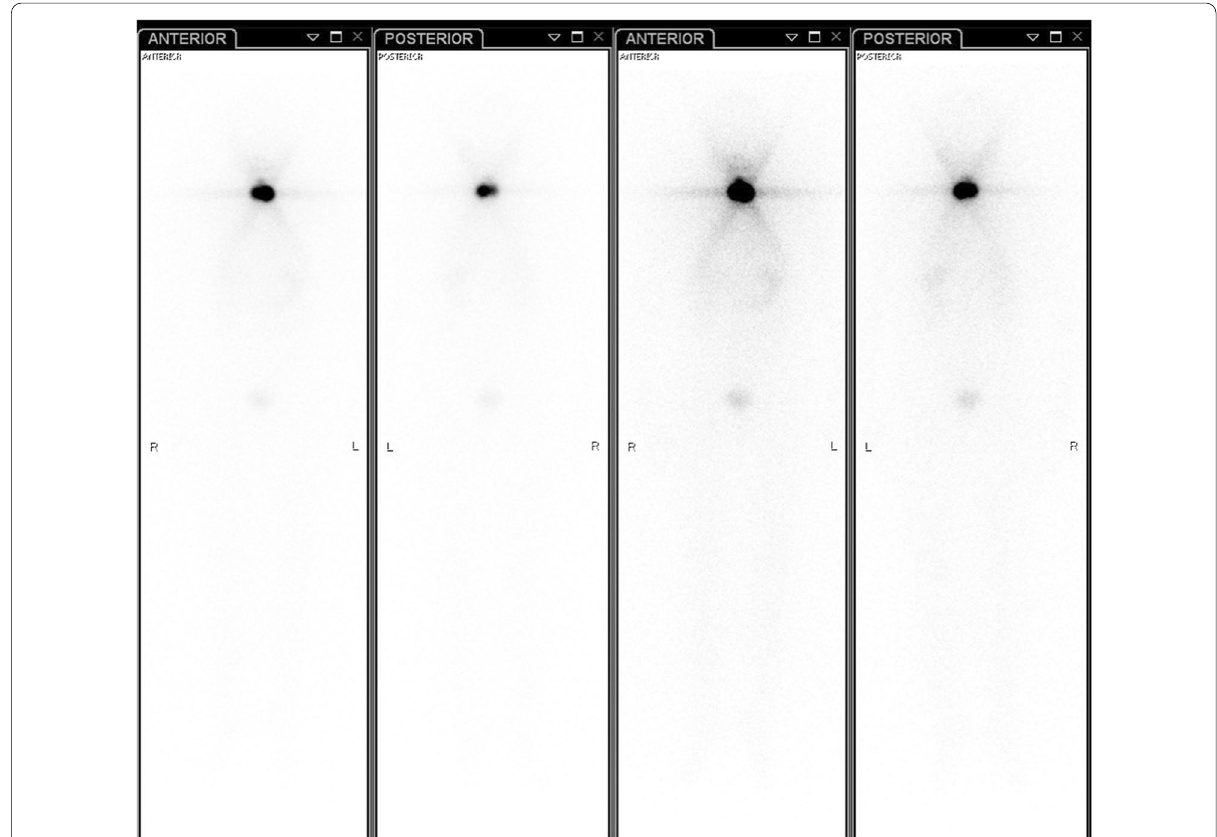
Fig. 3 Scan evidence of iodine avid functioning thyroid tissue in the neck. Uptake elsewhere is